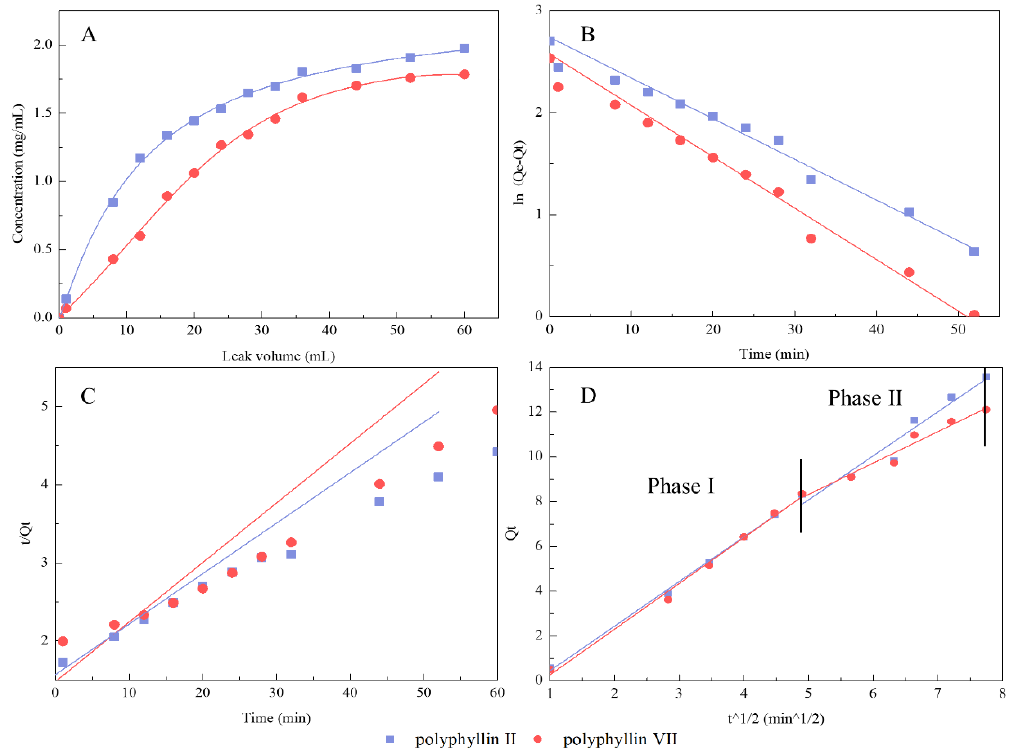
Figure 8. Linear correlation of leakage curve ( A ), pseudo-first-order model ( B ), pseudo-second-order model ( C ), and Weber-Morris intragranular diffusion model ( D ) of polyphyllin II and polyphyllin VII. Table 8. Two model fitting parameters of dynamic data on NKA-9.